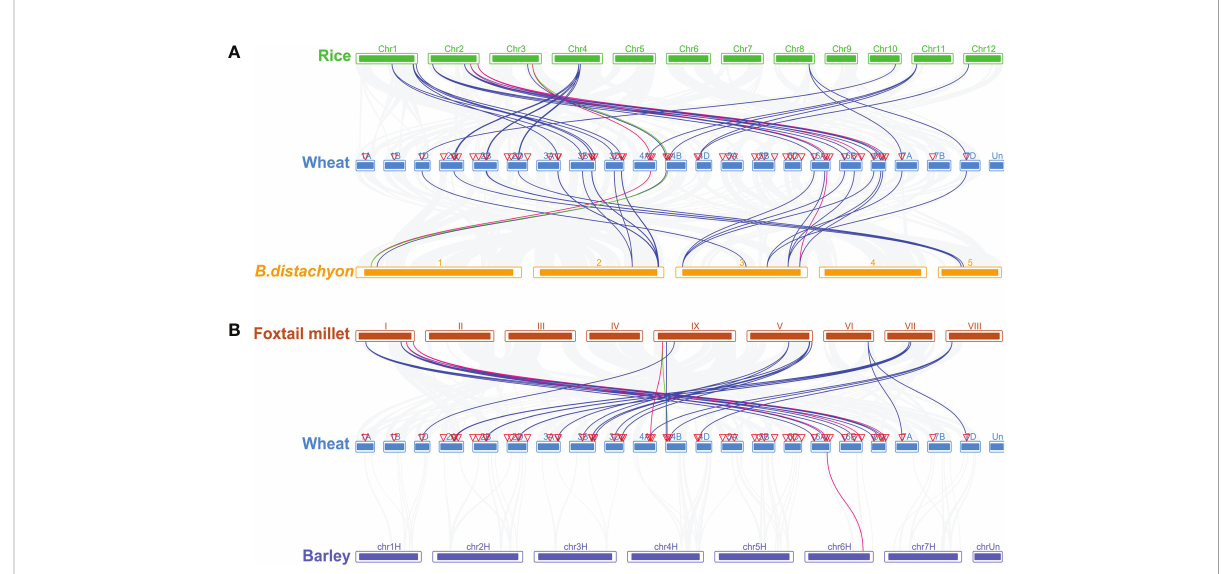
FIGURE 5 Homologous gene pairs between wheat and (A) Rice, and B.distachyon, (B) Foxtail millet, and Barley. There are gray lines in the background that indicate the collinear blocks within wheat genomes and other four plant genomes, while other colored lines highlight the collinear blocks centered on the A, B, and D chromosomes for wheat. It should be noted that the species names “ Wheat ” , “ B.distachyon ” , “ Rice ” , “ Barley ” , and “ Foxtail millet ” refer to Triticum aestivum , Brachypodium distachyum , Oryza sativa , Hordeum vulgare , and Setaria italica , respectively. Chromosomes are colored differently in different